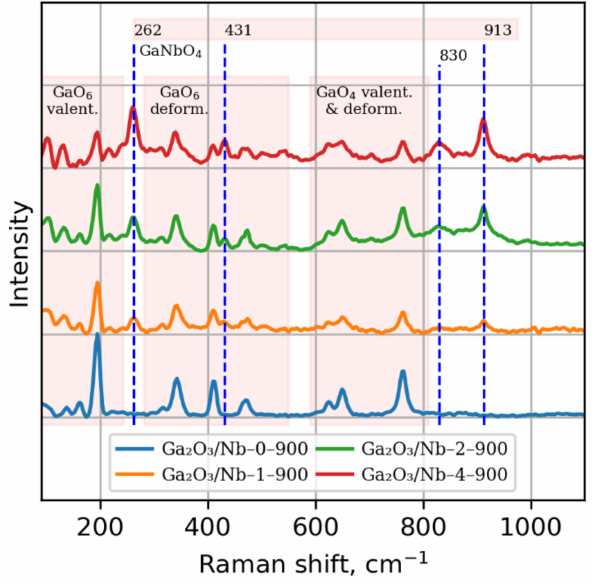
Figure 3. Raman spectra of Ga 2 O 3 /Nb-x-900 materials. Dash line marked peaks correspond to lattice oscillations in GaNbO 4 phase. Remaining peaks are attributed to valence and deformation lattice oscillations in β -Ga 2 O 3 phase.